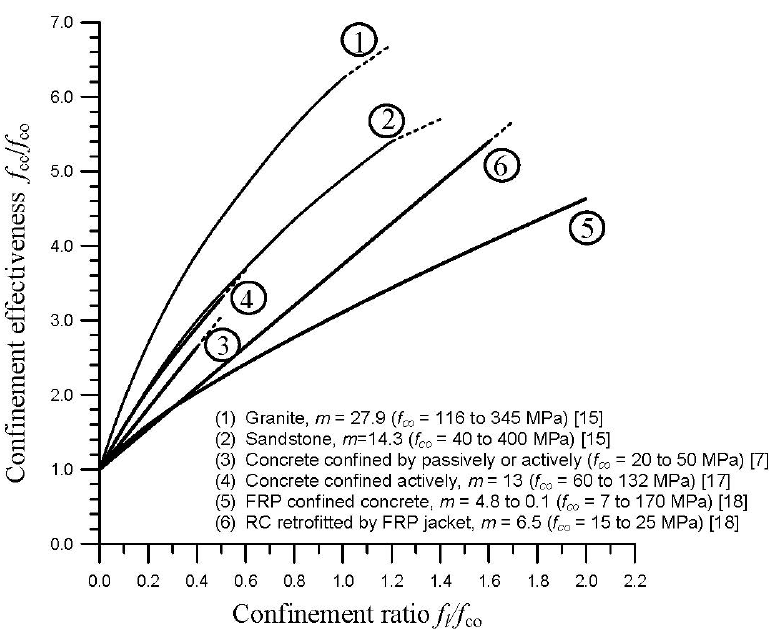
Figure 4. Failure envelopes of intact rock specimens and concrete confined by different confining materials. Reprinted with permission from [18]. Copyright 2009.